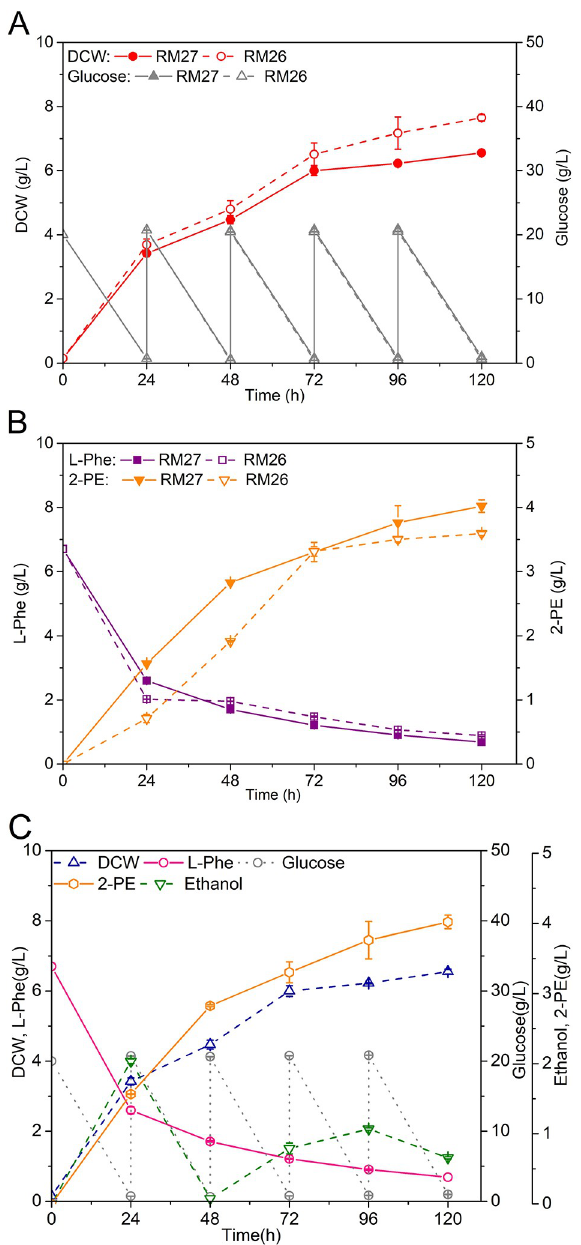
Fig 8. Fermentation view of yeast strains RM26 and RM27. (A) Cell growth, ethanol and glucose consumption of RM26 and RM27 in YSM medium with the addition of 20 g/L glucose every 24 h. (B) Improvement of 2-PE synthesis and L-phenylalanine consumption of RM26 and RM27 in YSM medium with the addition of 20 g/L glucose every 24 h. (C) Fermentation view of RM27 (AD032 pdc5 4 P TPI -ectyrB-llkdcA-scADH2 P TPI -strlgox) in YSM medium with the addition of 20 g/L glucose every 24